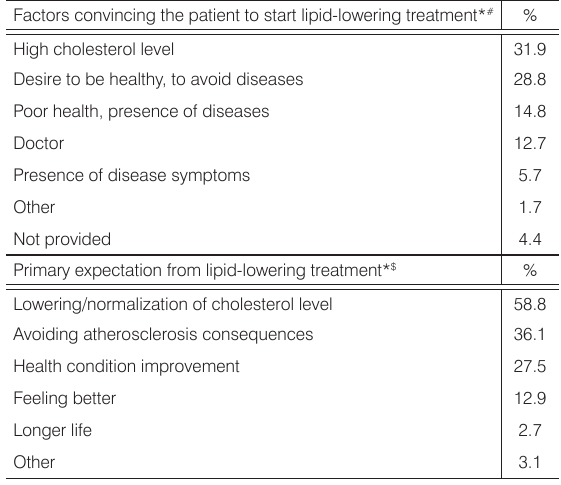
Table 3. Reasons to take up lipid-lowering treatment by the patient and expectations towards this